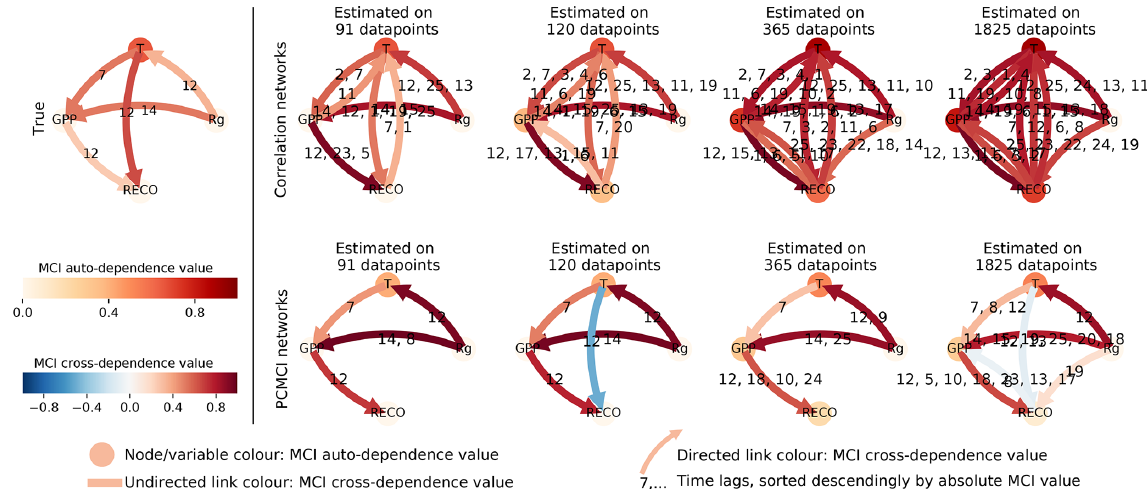
Figure 1. The artificial datasets are generated with a prescribed interaction structure (true network), which is obtained by fitting the test model to the FLUXNET sites. Here we show for four time series lengths the process graphs estimated via both lagged correlation and PCMCI. The data used stems from the homoscedastic realisation of the seasonality dataset of the Hainich site. The significance level was set to 0.01. The number of time lag labels were limited to five in the correlation networks. However, for the longest time series typically the whole range of lags (0–25) was significant.